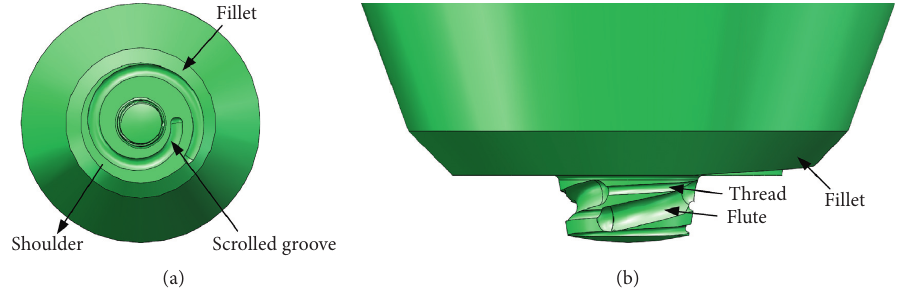
Figure 1: The tool used in welding experiments. (a) Vertical view; (b) front view.